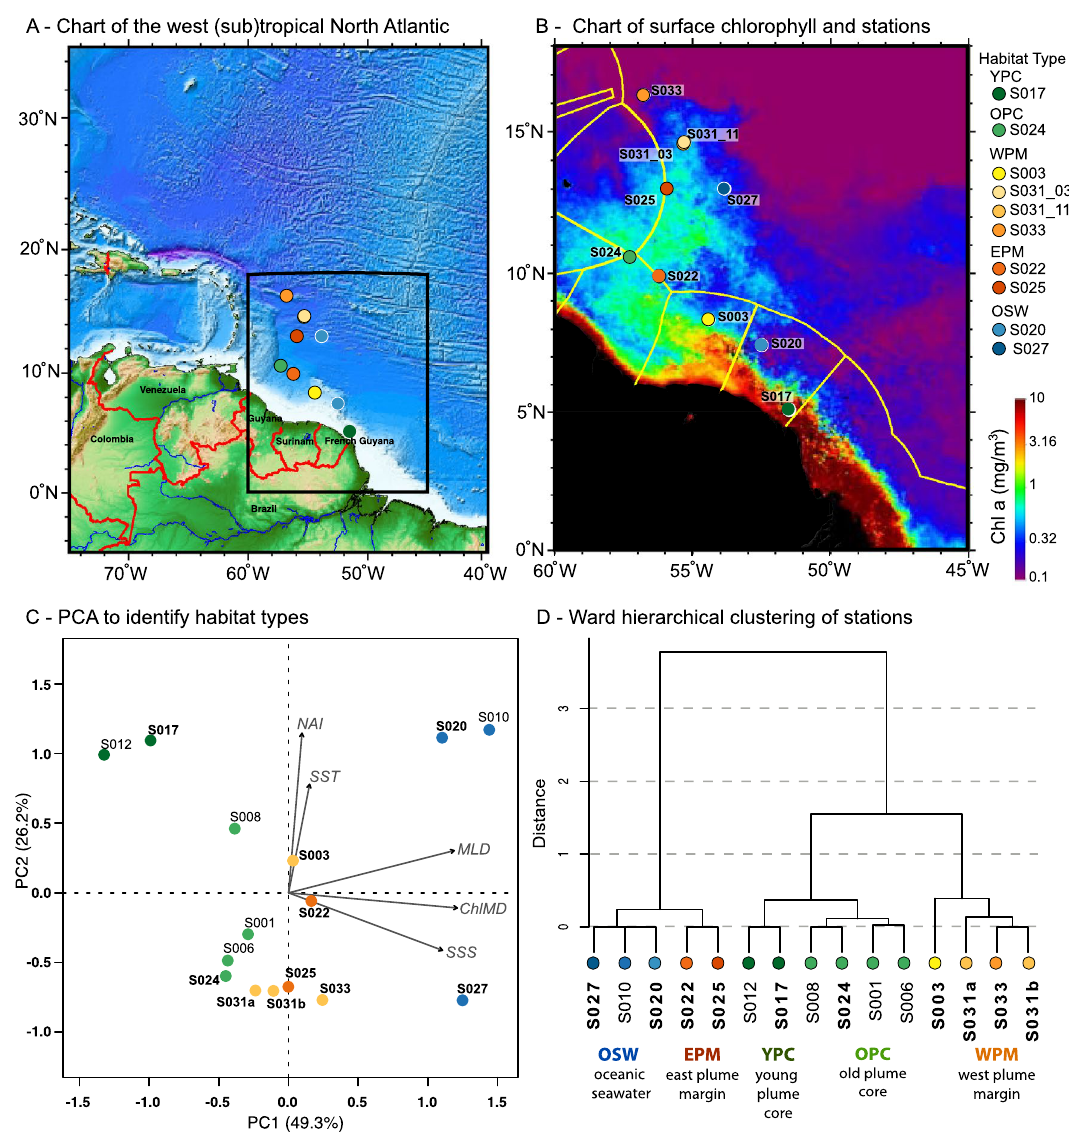
Figure 1. Location of the study ( A ), distribution of sampling stations ( B ) and identification of the habitat types using a principal component analysis ( C ) and Ward’s hierarchical cluster analysis ( D ). The map in B shows the monthly composite surface chlorophyll concentration for May 2018 from satellite observations Reprocessed L4 (ESA-CCI: OCEANCOLOUR_GLO_CHL_L4_REP_OBSERVATIONS_009_093) downloaded from Copernicus Marine Service (https:// resou rces. marine. coper nicus. eu). The map was created using the NASA SeaDAS 7.5.3 software with land and exclusive economic zones boundaries (yellow lines) added with gmt v5.4.5 software. Note that all stations from EN614 were used to establish habitat types, but only the 10 stations highlighted in bold and shown on the map were used in this study. SSS, sea surface salinity; SST, sea surface temperature; NAI, nitrogen availability index; MLD, mixed layer depth; ChlMD, chlorophyll maximum P3 (5.6–23% of counts), except for station S022 whose chlorophyll maximum small pigmented eukaryote com- munity was dominated by P3 (93% of counts). All chlorophyll maximum communities were characterized by a low contribution of P4 (0.6–6.2% of counts). The small pigmented eukaryote community collected from 40 m at S017 was characterized by the presence of population P6 (16% of counts), absent from the other stations. P1 was only present at the chlorophyll maximum of the OPC station (11% of counts). However, the amount of DNA extracted from P1 was too small to allow for sequencing of the 18S rDNA and it is therefore not part of the subsequent analyses. At the surface, small pigmented eukaryotes contributed on average 1.3 ± 0.4% of the total small phytoplankton abundance (Supplementary Table S1), indicating that picocyanobacteria dominated all stations. Synechococcus dominated cell abundances at most stations (57–97%), except in the OSW (S020, S027) where Prochlorococcus dominated (92–97%). These results reflect the established paradigm that the eukaryotic component of small